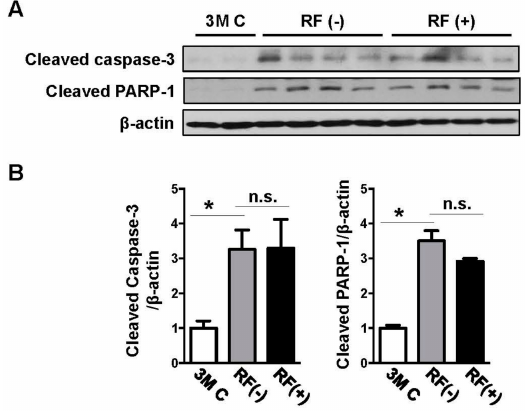
Figure 4. Effects of RF-EMF exposure on the protein expression levels of cleaved caspase-3 and cleaved PARP-1 as determined by western blotting analysis. ( A ) Western blotting images of cleaved caspase-3 and cleaved PARP-1 in the mouse brain following RF-EMF exposure. ( B ) The graphs show the quantification of cleaved caspase-3 and PARP-1 levels in the young-aged (3M C), sham-exposed (RF ( − )), and RF-exposed (RF (+)) mouse brain based on band intensity. The values are presented as means ± SEM. * p < 0.05 versus young-aged (3M C) group. n.s.: no